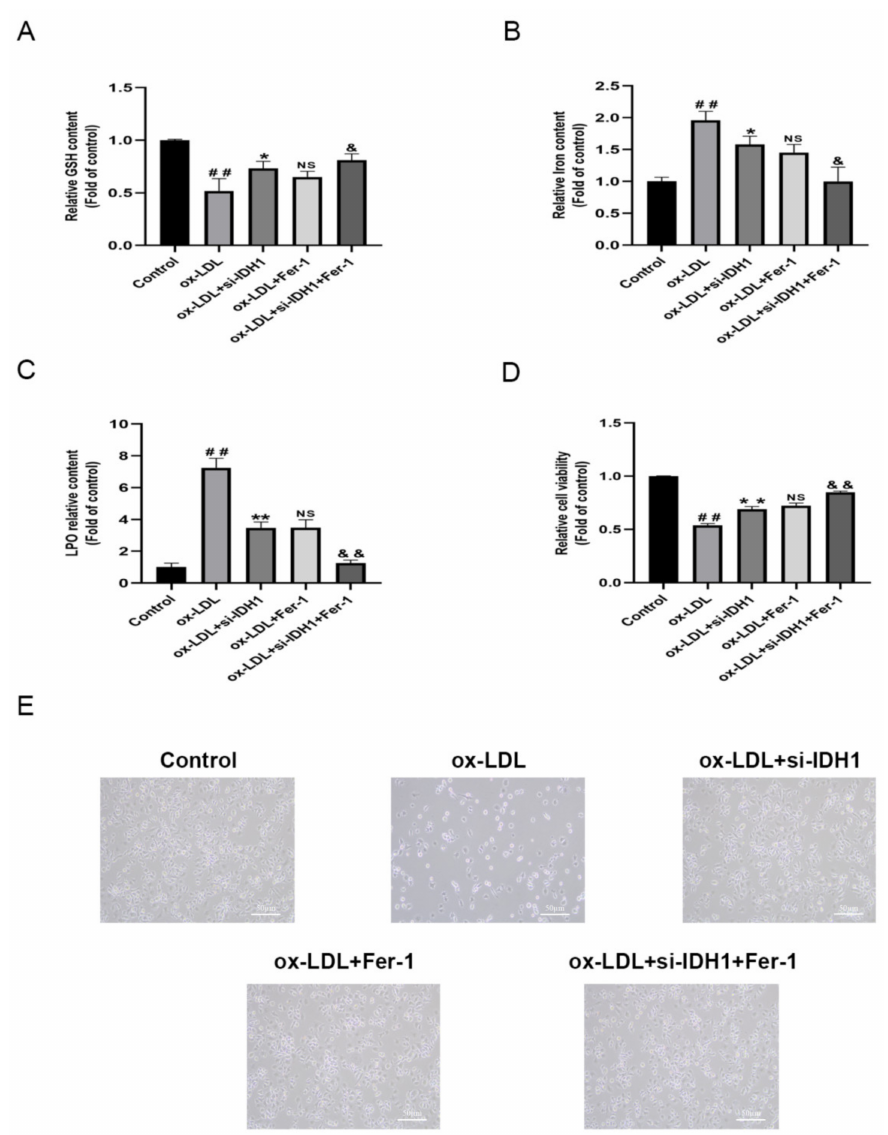
Figure 5. Inhibition of IDH1 ameliorates ox-LDL-induced ferroptosis. ( A ) The levels of GSH. ( B ) The level of iron content. ( C ) The total content of LPO. ( D ) Cell survival determined by CCK-8. ( E ) The brightfield images showing dead cells (Scale bars = 50 µ m). ## p < 0.01 vs. control group; * p < 0.05, ** p < 0.01 vs. ox-LDL-treated group; NS vs. ox-LDL and si-IDH1 treatment group. & p < 0.05, && p < 0.01 vs. ox-LDL and Fer-1 treatment group. NS, not significant. Data are presented as mean ±